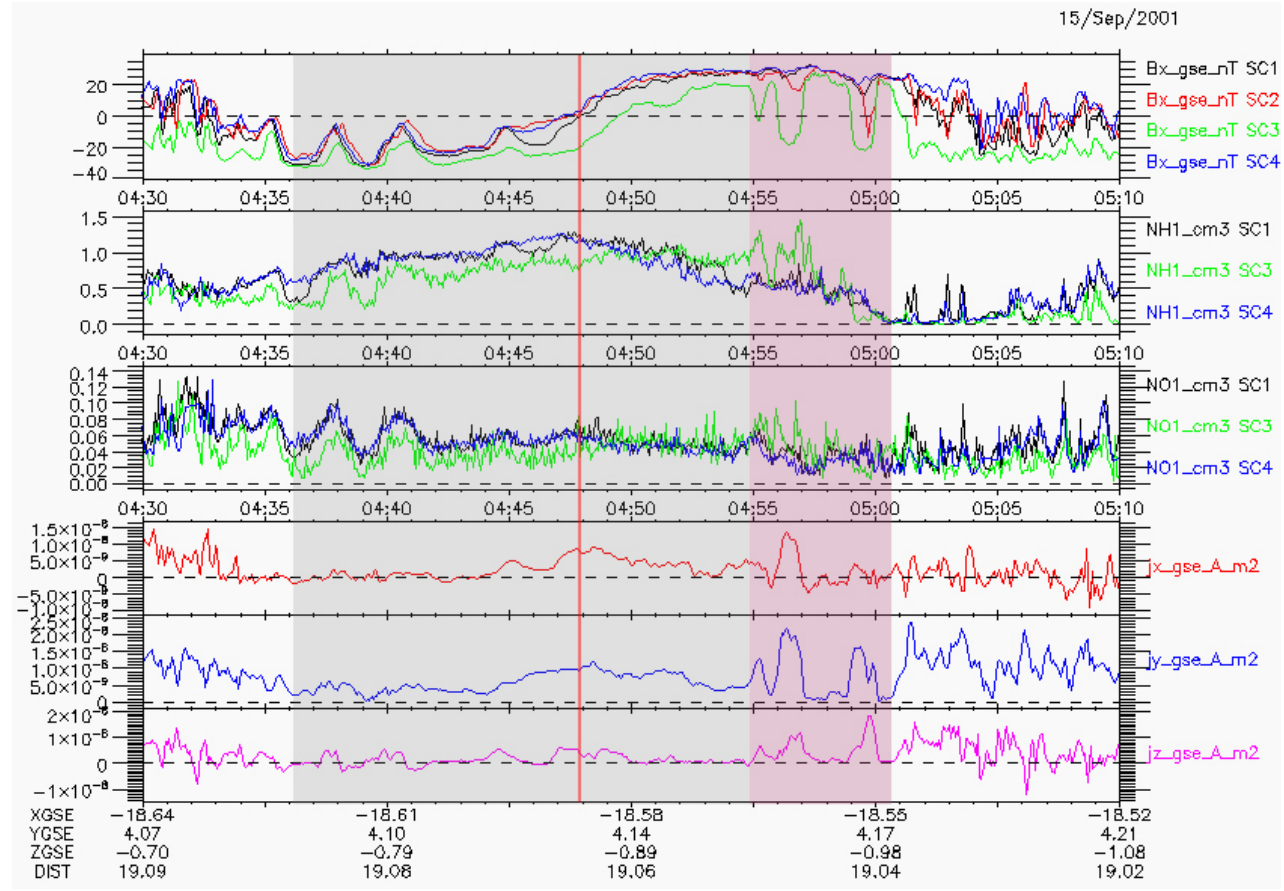
Fig. 2. Overview of the Harris-like current sheet. (a) B x for four satellites. (b) and (c) are the proton and oxygen ion densities, respectively. (d–f) are the current density components.